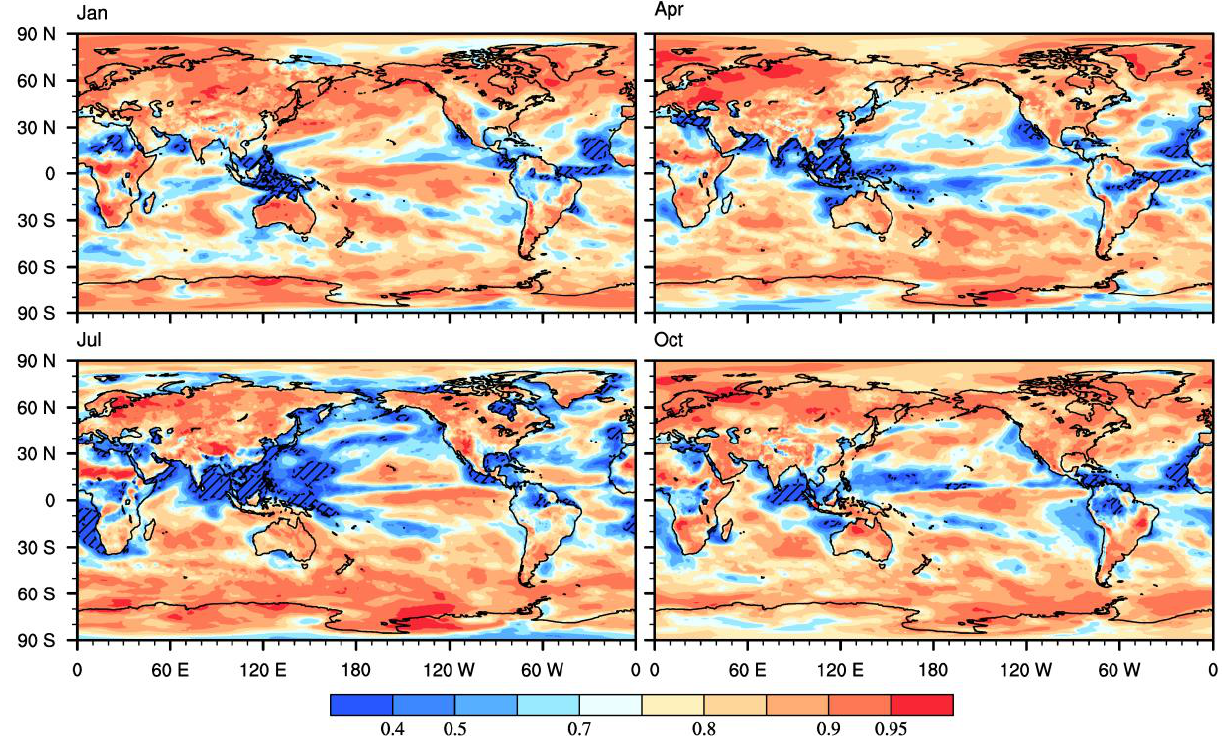
Figure 1. Distributions of the correlation coefficient between W and surface vapor pressure E , calculated with monthly data from 43 years. The areas where the correlation is not significant at the 0.05 level are marked with diagonal lines.